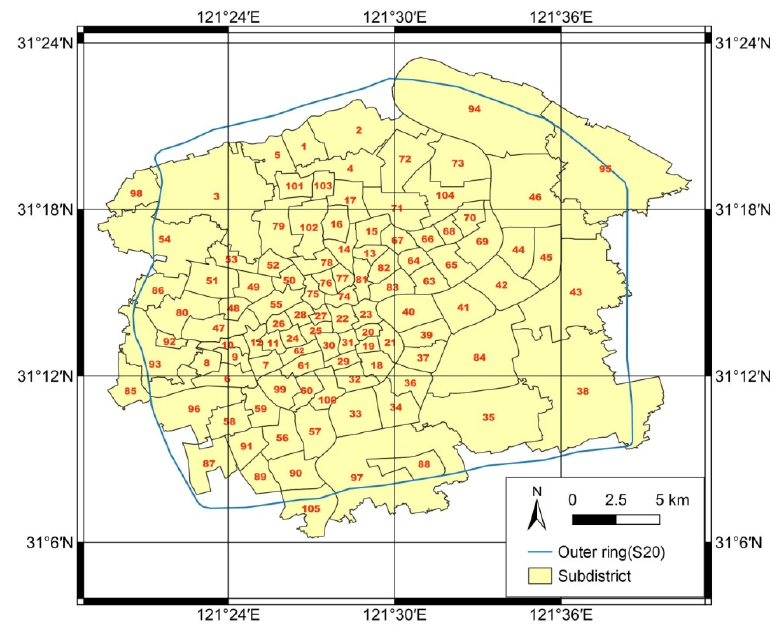
Figure 4. The 105 subdistricts of the Shanghai central city.